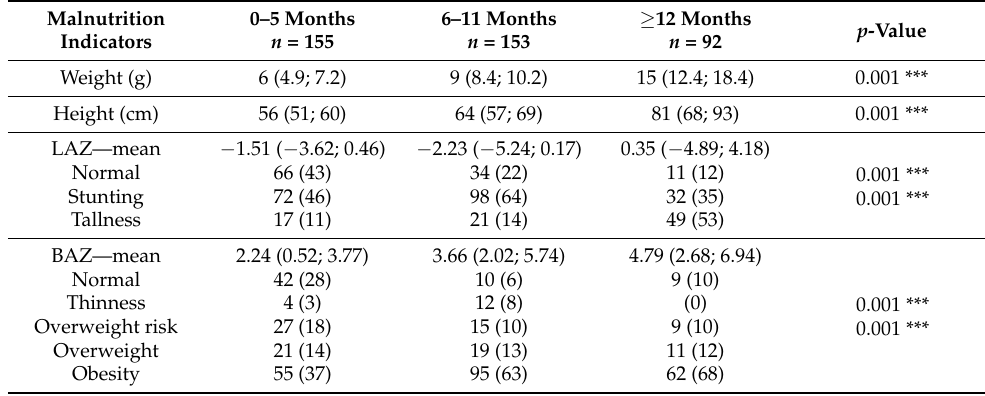
Table 4. Comparison of medians and prevalence of stunting and obesity among children by age. Malnutrition Indicators